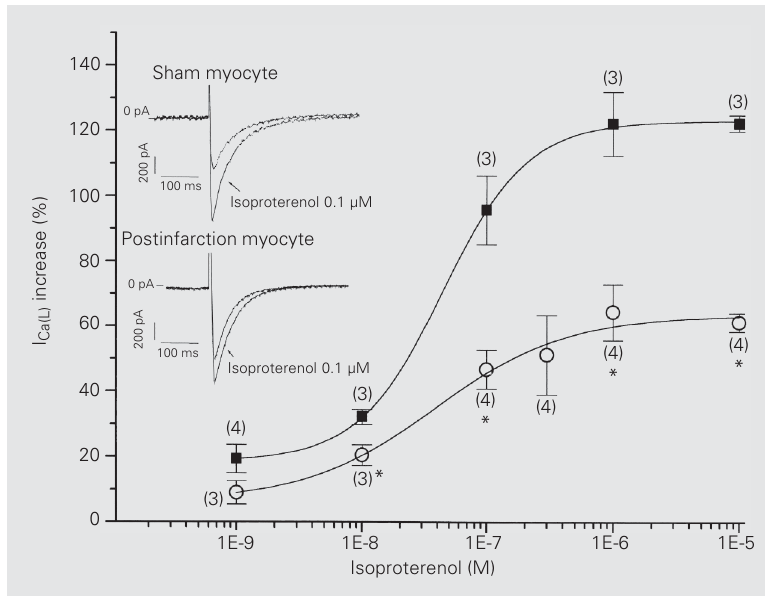
Figure 2. Dose-response curves for isoproterenol on L-type calcium current (I Ca(L) ). Note the smaller increase of I Ca(L) density in postinfarction (circles) than in sham myocytes (squares): E max was 63.6 ± 4.3% in postinfarction and 123.3 ± 0.9% in sham myocytes, P<0.001. The